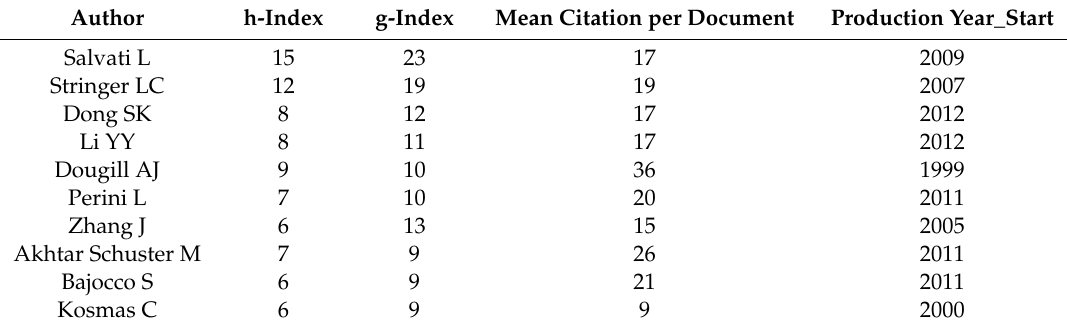
Table 3. Top 10 influential authors in the field of land